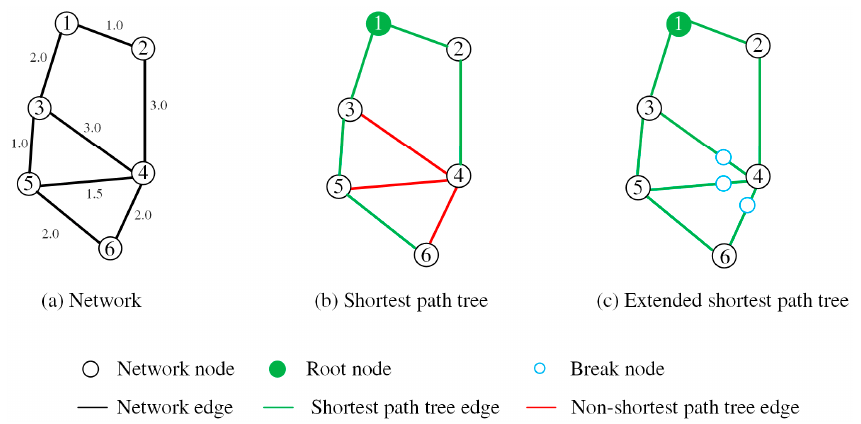
Figure 3. Demonstration of an extended shortest path tree.